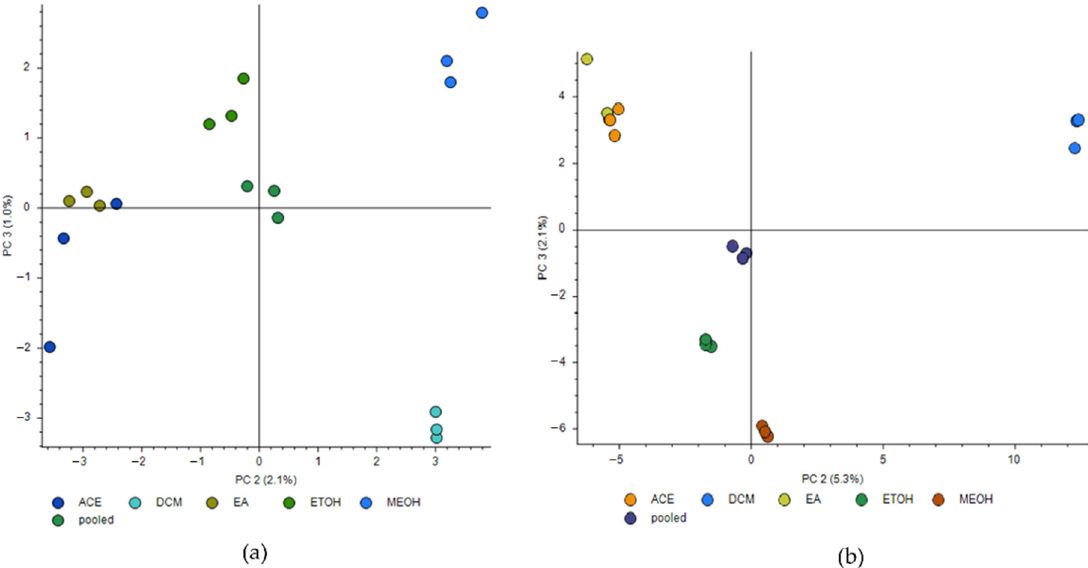
Figure 8. Principal component analysis (PCA) score plots of different solvent E. foeminea crude extract LC–MS data per injection. ( a ) negative mode scan; ( b ) positive mode scan. Ace, acetone extract; DCM/MeOH, dichloromethane/methanol extract; EA, ethyl acetate; EtOH, ethanol; MeOH, methanol. Samples were analyzed in triplicates.